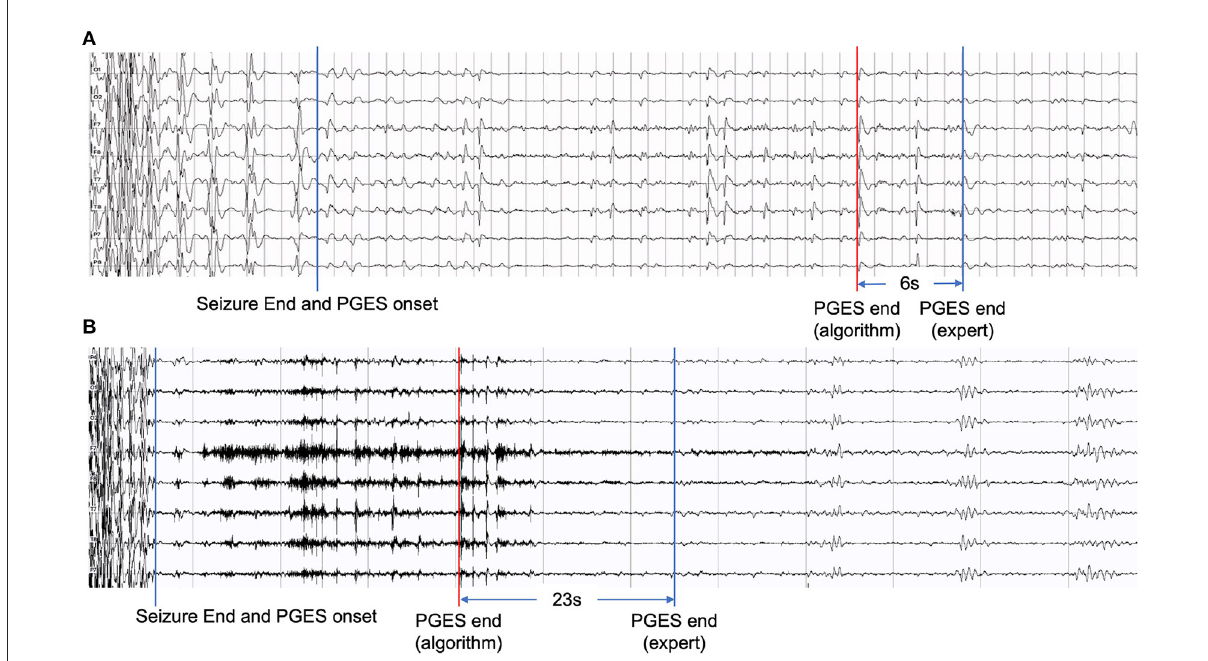
FIGURE6 Examples of EEG recordings with false positives: (A) with a time distance of 6 seconds and (B) with a time distance of